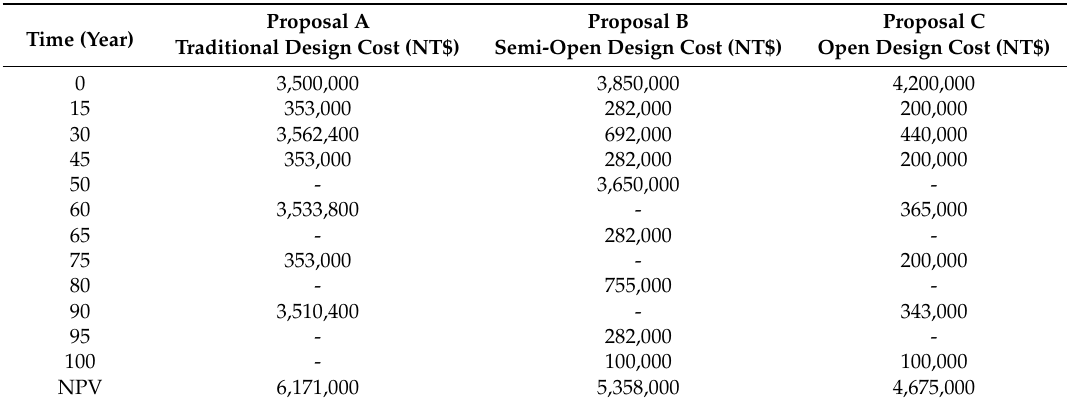
Table 2. Life cycle cost analysis of the three